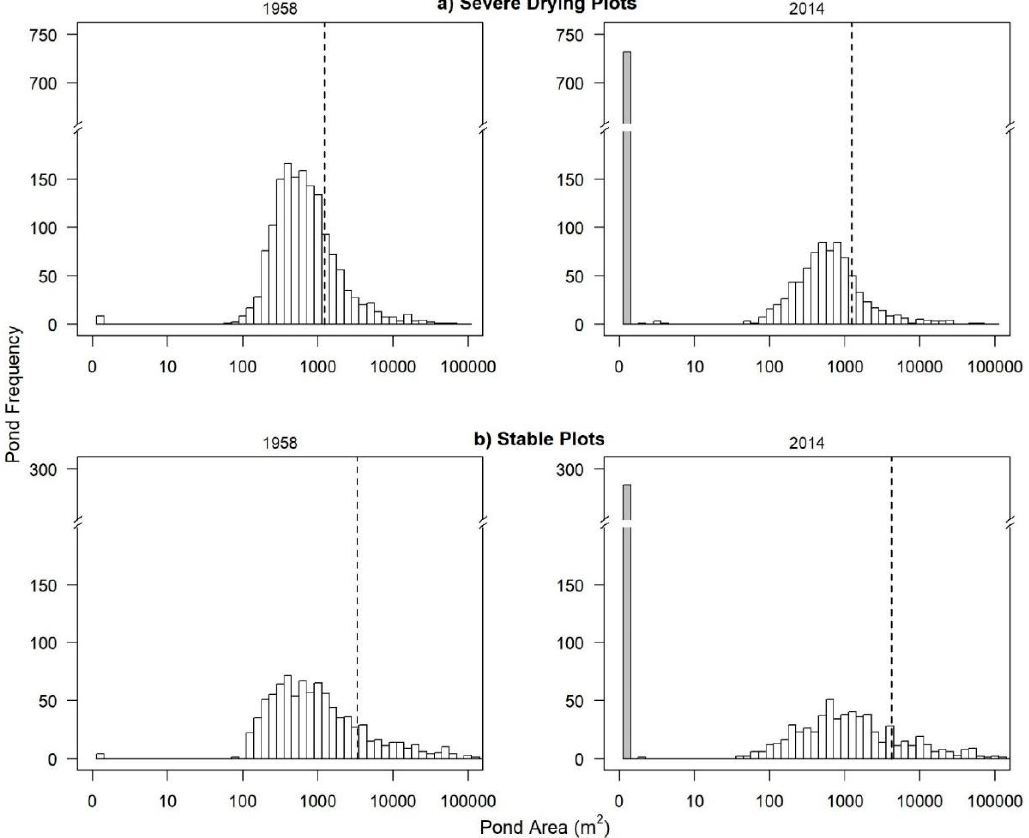
Figure 4. Size distributions of waterbodies mapped using aerial imagery, split by plot type and year. The dashed black lines show the average waterbody size within that year and plot, excluding waterbodies with a size of 0 m 2 . The grey bars in 2014 show the number of waterbodies that experienced complete drainage. Table 2. Observed and expected size class distributions of waterbodies in severe drying and stable plots, based on the chi-square analysis. Bold numbers indicate that the number of observed waterbodies exceeds the number of expected waterbodies. Numbers with an asterisk indicate a significant difference from the expected value, using a Bonferroni correction ( p < 0.0063). Severe Drying Stable Observed Expected Observed Expected